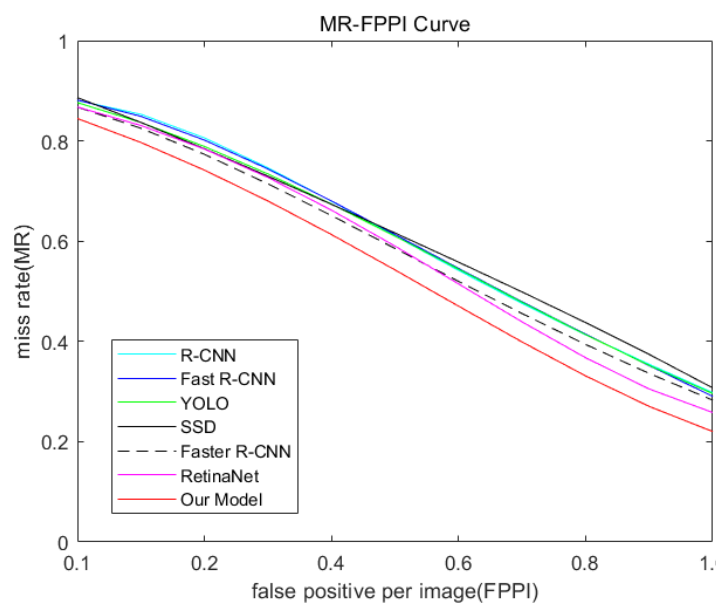
Figure 9. The MR-FPPI curves of the seven tested methods.